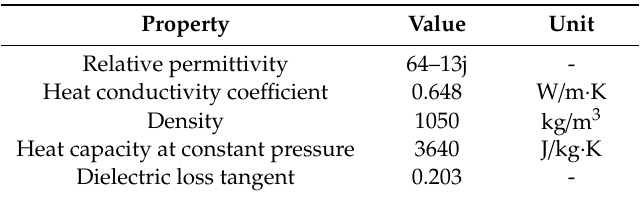
Table 3. Related input parameters of pear.